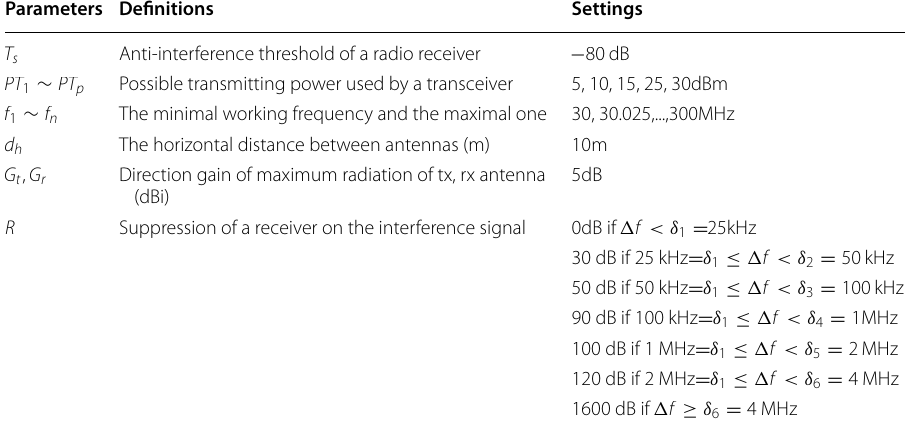
Table 1 Parameters and settings for simulation Parameters Definitions Settings T s Anti-interference threshold of a radio receiver − 80 dB PT 1 ∼ PT p Possible transmitting power used by a transceiver 5, 10, 15, 25, 30dBm f 1 ∼ f n The minimal working frequency and the maximal one 30, 30.025,...,300MHz d h The horizontal distance between antennas (m) 10m G t , G r Direction gain of maximum radiation of tx, rx antenna (dBi) R Suppression of a receiver on the interference signal